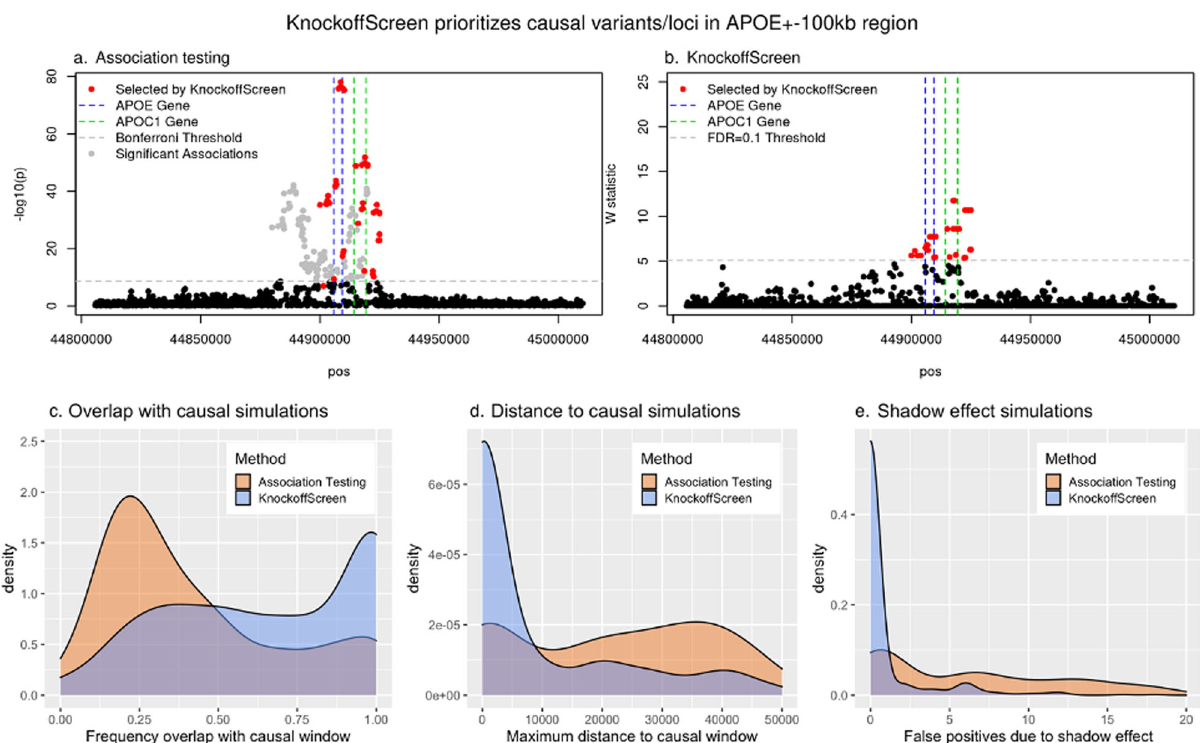
Fig. 4 KnockoffScreen prioritizes causal variants/loci and distinguishes the signal due to rare variants from shadow effects of signi fi cant common variants nearby. a , b Results of the data analyses of the APOE ± 100 kb region from the ADSP data. Each dot represents a window. Windows selected by KnockoffScreen are highlighted in red. Windows selected by conventional association testing but not by KnockoffScreen are shown in gray. c – e Simulation results based on the APOE ± 100 kb region, comparing the conventional association testing and KnockoffScreen methods in terms of c , frequency of selected variants/windows overlapping with the causal region; d Maximum distance of selected variants/windows to the causal region; e number of false positives due to shadow effect. The target FDR is 0.1. The density plots are based on 500 replicates. Source data are provided as a Source Data fi Fig. 4e. For a fair comparison, for the conventional association